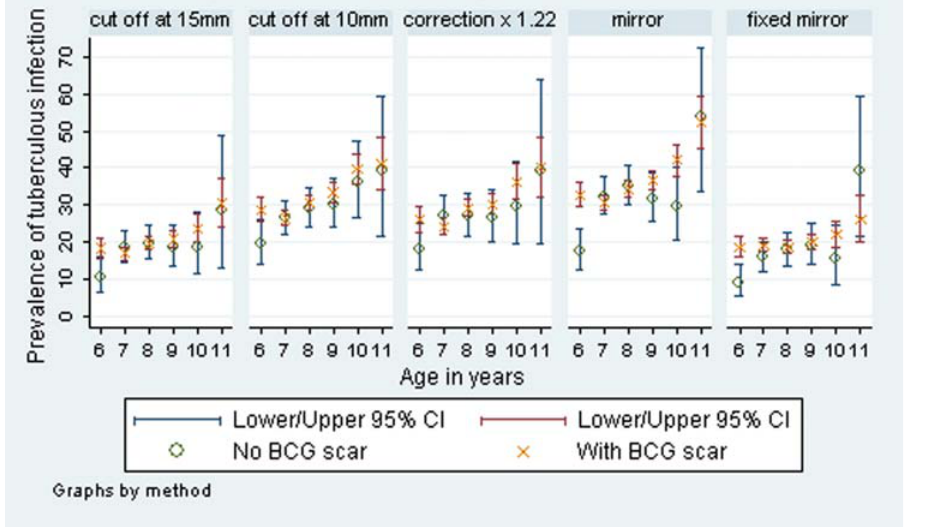
Figure 4. Prevalence of tuberculous infection with 95% binomial exact CIs, as calculated using five methods, by BCG and age for South Africa.